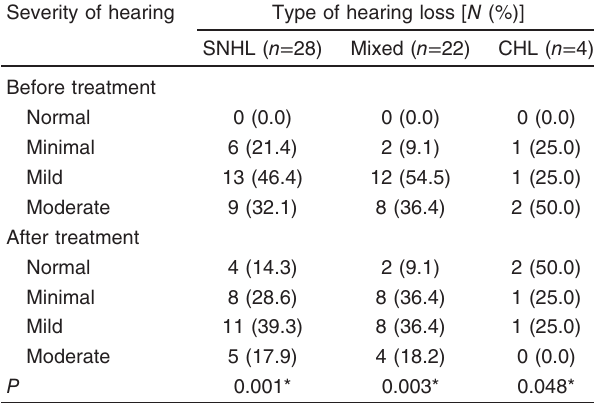
Table 8 The progress of the average hearing threshold level after achieving an euthyroid state for 6 months ’ period Severity of